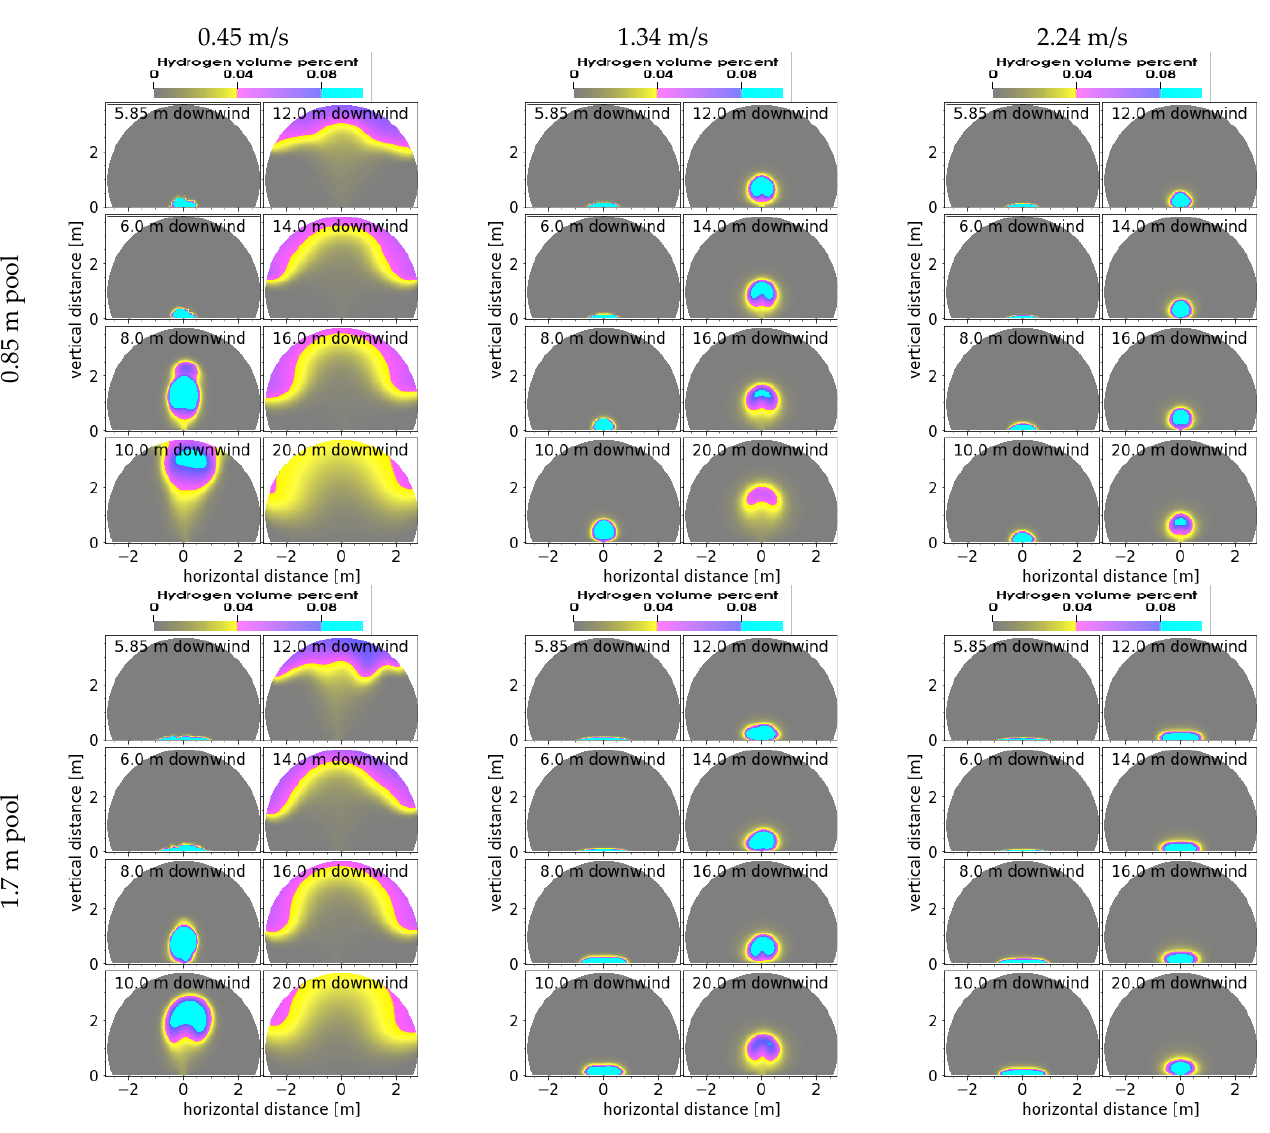
Figure 7. Cross-sections of the 4% and 8% mole fractions at selected downwind distances for the 0.85 m ( top ) and 1.7 m ( bottom ) diameter pool at three crosswind speeds, as shown in the top labels, after the plume is at steady-state.